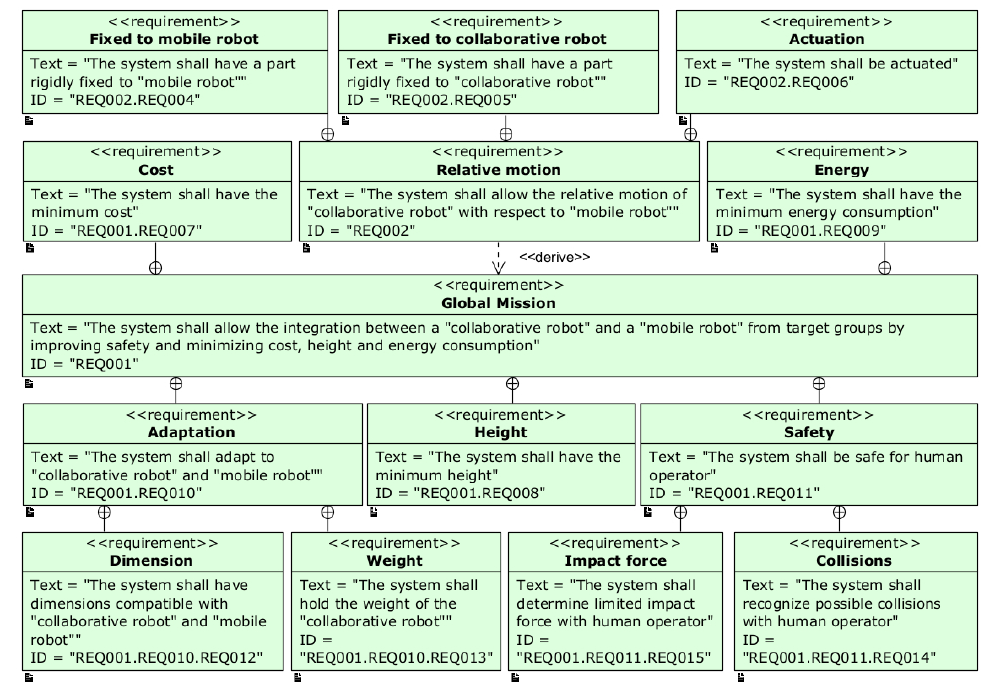
Figure 8. Initial requirements related to the “Global mission” of the